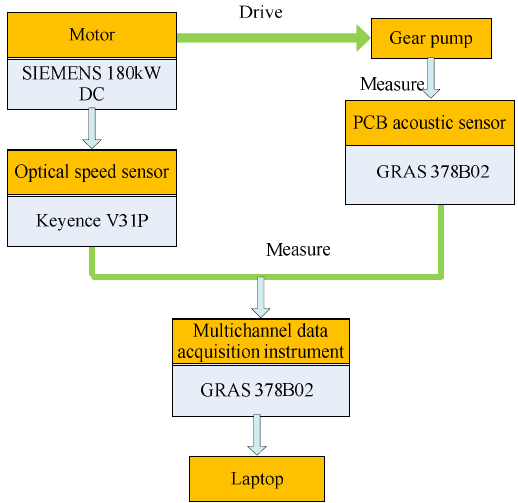
Figure 5. Schematic diagram of noise measurement.